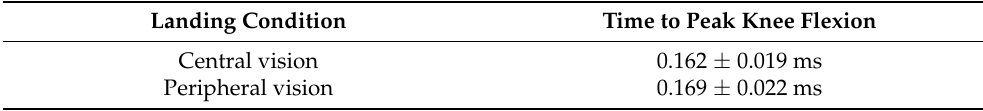
Table 2. Time to peak knee